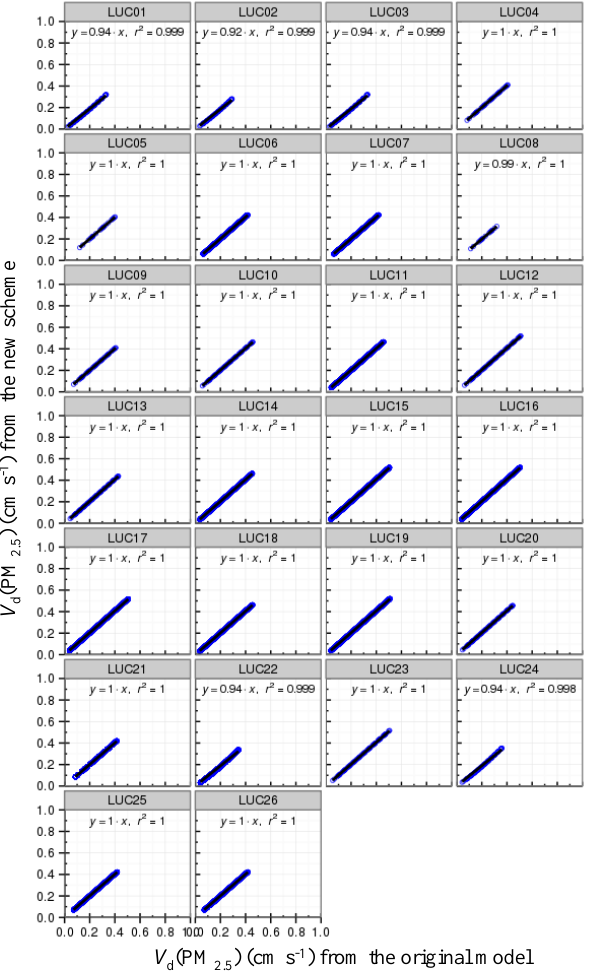
Fig. 3. Bulk V ds (PM 2 . 5 − 10 ) as a function of u ∗ . Solid lines repre- sent regression equations, and circles represent data